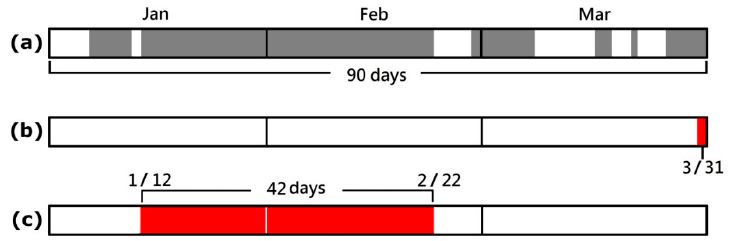
Figure 1. An example to show a dry event in the spring of 1987 at Taipei station with its 90-day window, presented by ( a ) daily rainfall less than 1mm (gray shading), ( b ) the DSidx (red shading) [44], and ( c ) the Taiwan Meteorological Drought index (TMD index) (red shading) [40]. For making a comparison with the DSidx, the rainfall data from the same six CWB conventional weather stations used in the DSidx was applied into our method to compute and the results were